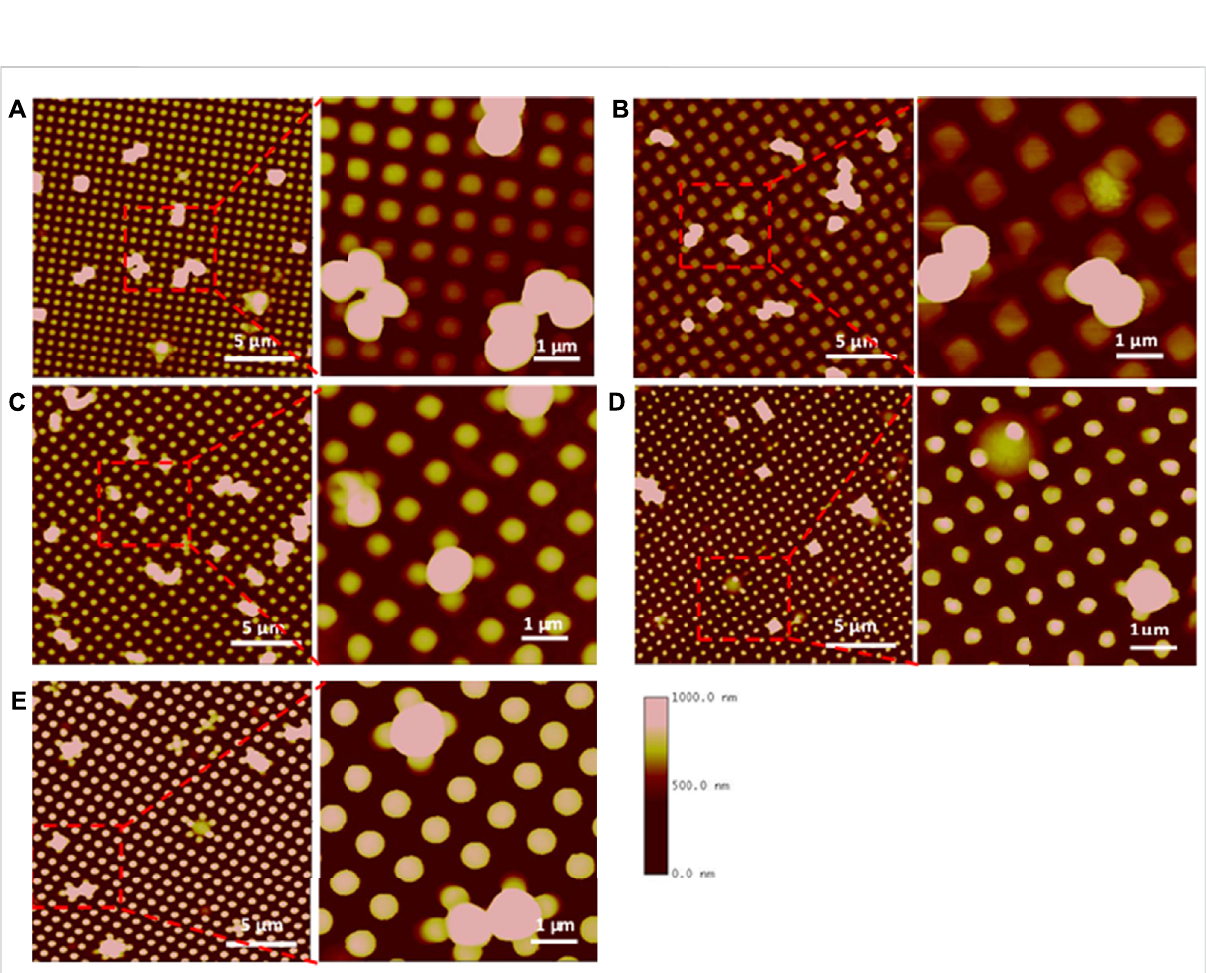
FIGURE 2 AFM images of S. aureus adhesion on textured surfaces. Square shaped pillars: Pattern 1, 500/300/500 (A) , Pattern 2, 700/700/300 (B) , Pattern 3, 500/500/600 (C) . Round shaped pillars: Pattern 4, 400/400/600 (D) , Pattern 5, 500/500/600 (E) . Bacterial cells are captured in Pattern 3 or penetrated by the pillar in Pattern 4. Reprinted from Xu and Siedlecki, Journal of Biomedical Materials Research Part A, 2022.110, 1238 –